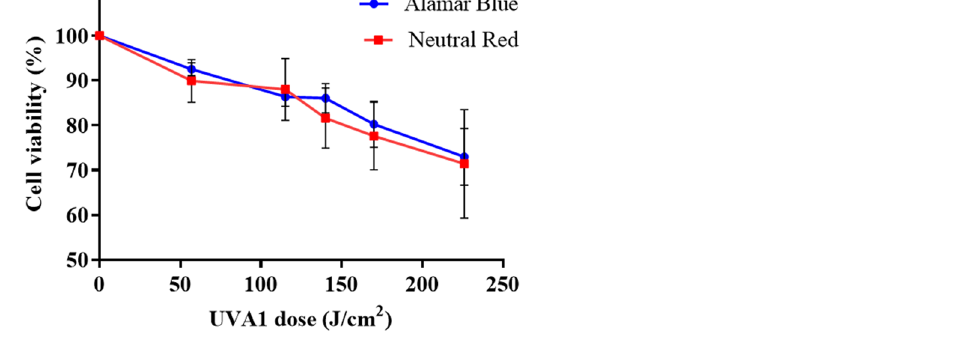
Figure 4. Dose–response cell viability 24 h post irradiation using Alamar Blue and Neutral Red assays. Both assays showed a significant dose dependent decrease in cell viability (Alamar Blue— p < 0.0001; Neutral Red p < 0.01; n = 3, linear regression analysis) with no significant difference between both assays ( p > 0.05; n = 3, linear regression analysis). Data represent mean ± SD of three separate